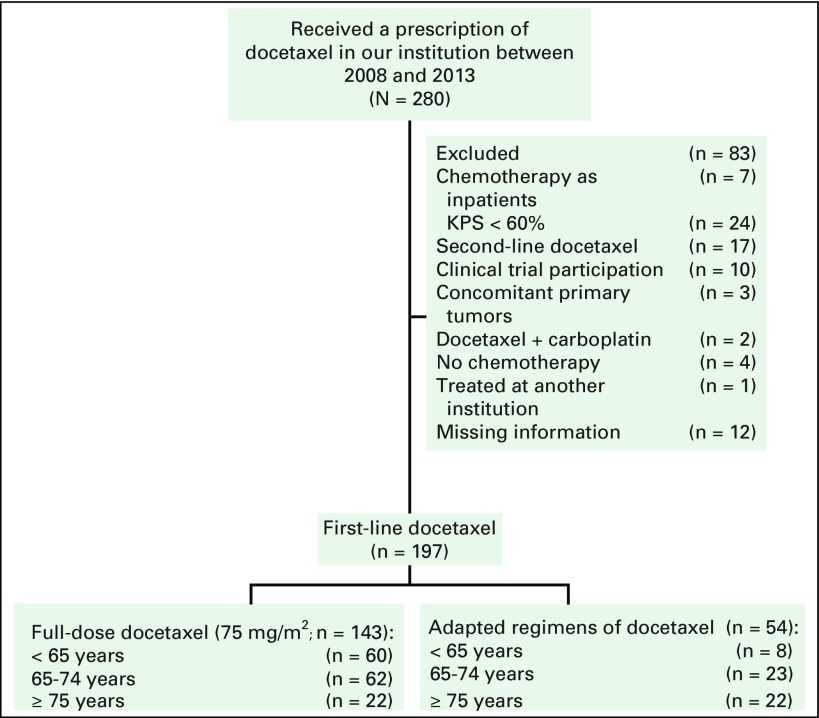
Flow chart. A total of 280 patients were identified initially; 83 were
excluded on the basis of exclusion criteria (inpatients when received
chemotherapy [n = 7]; Eastern Cooperative Oncology Group performance
status > 2 [n = 24]; received a previous chemotherapy regimen [n
= 17]; received docetaxel as part of a study protocol [n = 10]; another
concomitant primary tumor [n = 3]; received docetaxel combined with
carboplatin [n = 2]; did not receive any chemotherapy [n = 4]; received
the treatment at another institution [n = 1]; or did not have enough
information on charts [n = 12]). KPS, Karnofsky performance status.